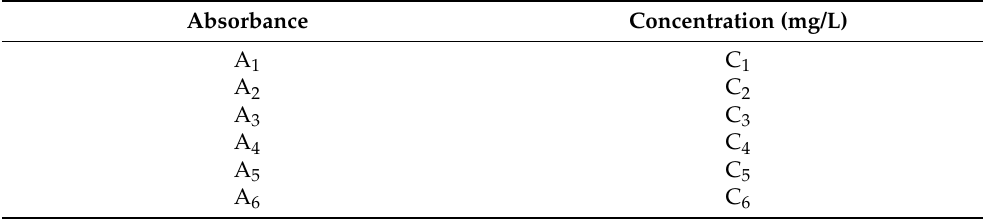
Table A1. Data of the absorbance values vs. concentration of vitamin B12.